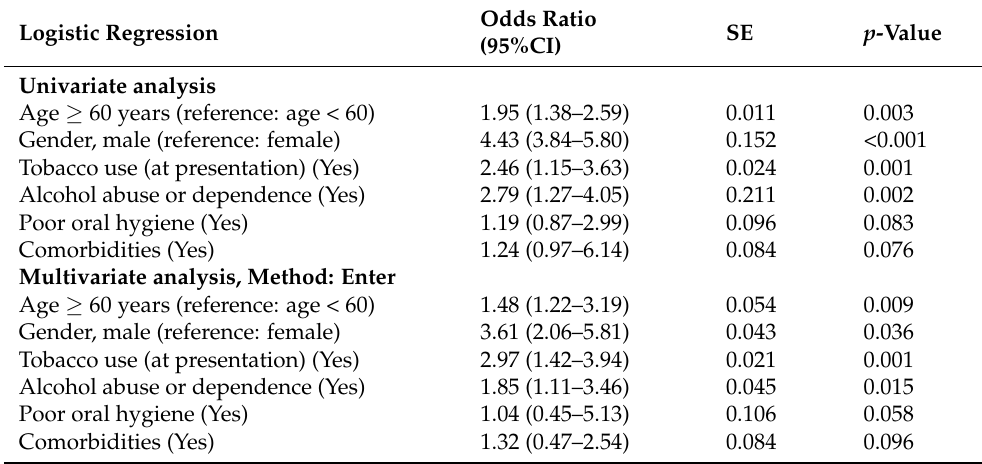
Table 3. Univariate and multivariate logistic regression for predicting the occurrence of carcinomas of the oral mucosa.